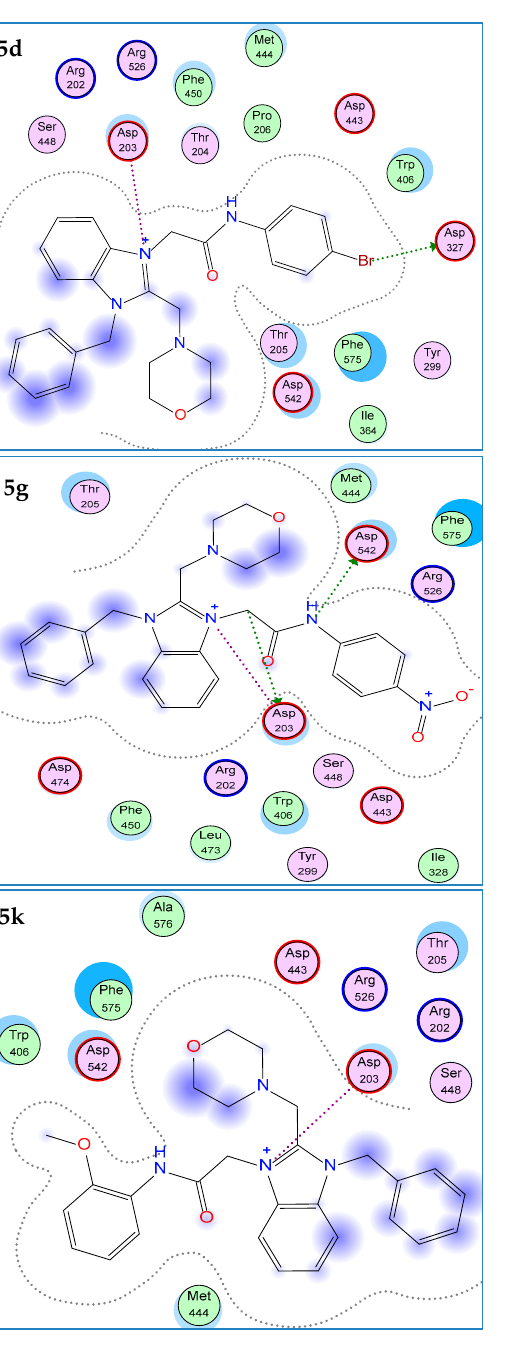
Figure 2. Two-dimensional interaction modes of potent compounds ( 5d , 5f , 5g , 5g and 5k ) and standard drug, acarbose. The blue color indicates ligand exposure, and the green-colored dotted lines indicate the interactions of receptor enzyme with ligands .